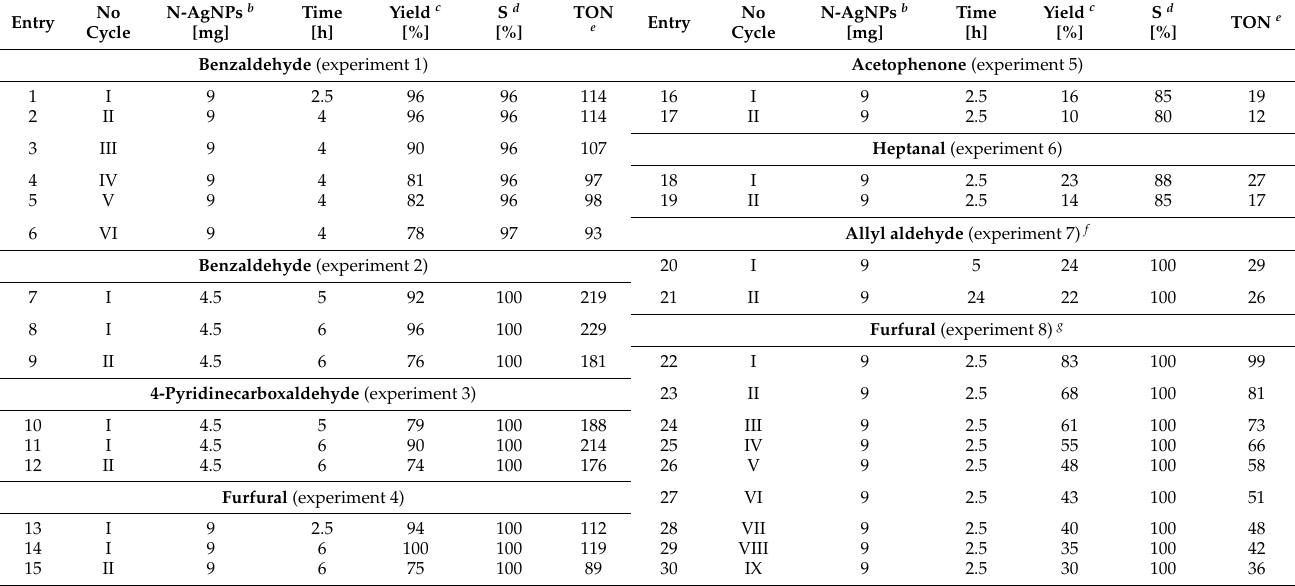
Table 3. N-AgNPs in catalytic oxidation of selected alcohols to given products a